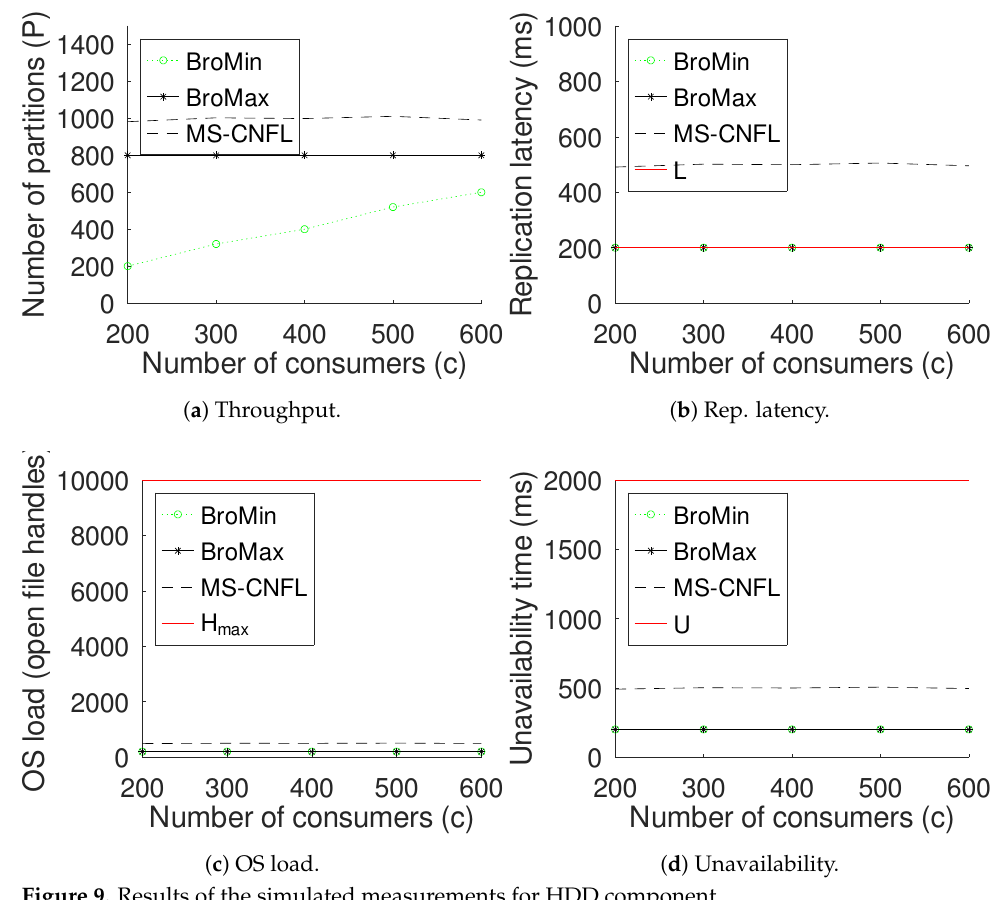
Figure 9. Results of the simulated measurements for HDD